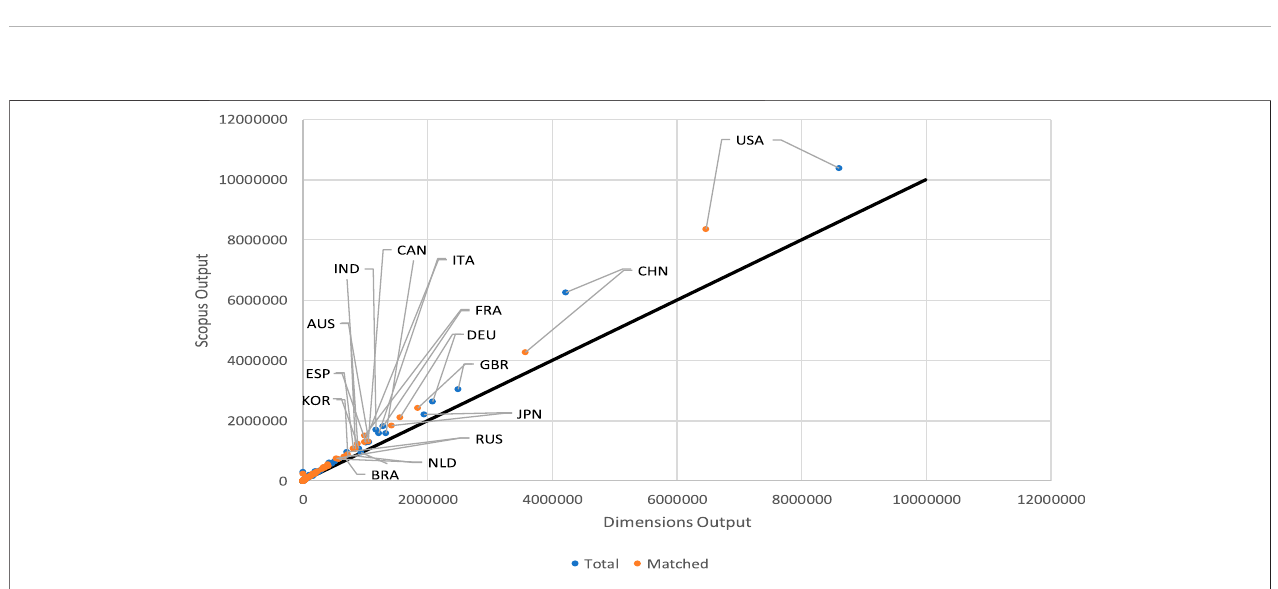
FIGURE 1 | Scatter plot of the total and matched Dimensions/Scopus output by country.